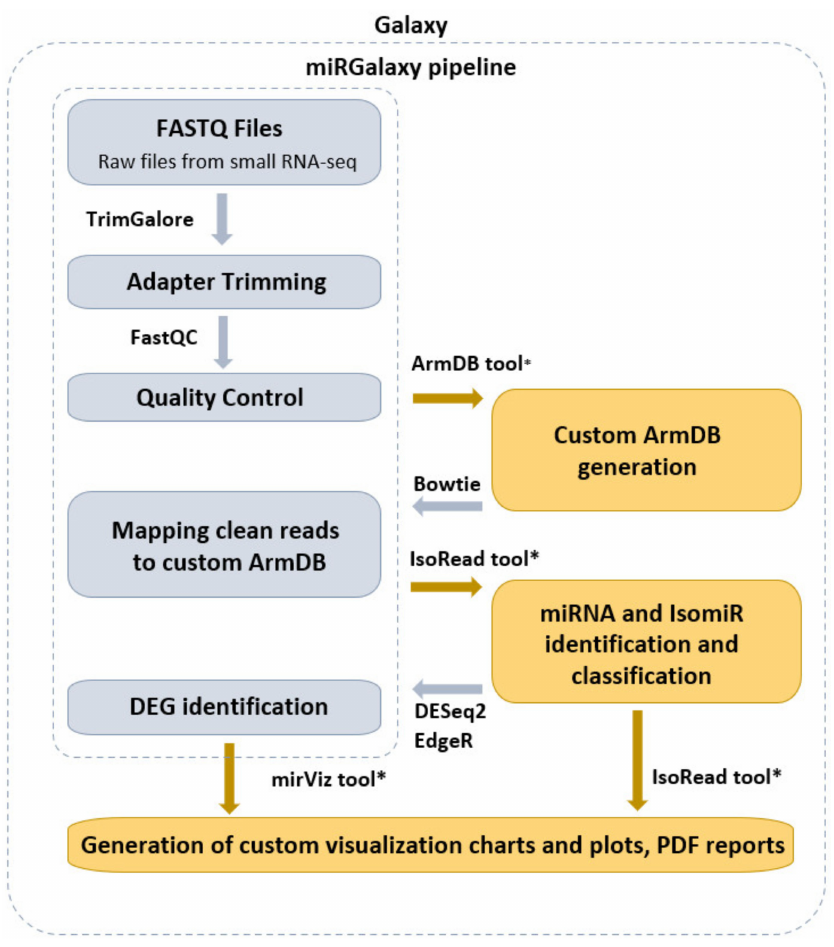
Figure 1. miRGalaxy workflow overview (the tools marked with an asterisk are newly developed for the miRGalaxy